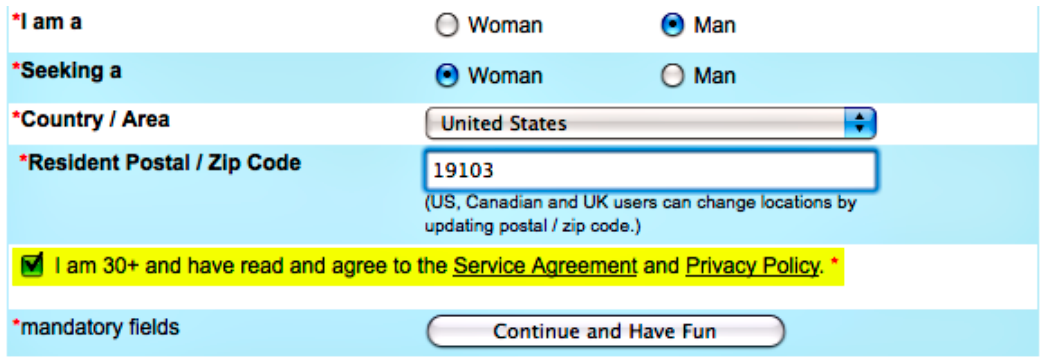
Figure 4. Taken from SeniorMatch.com registration page (highlight added) [39].